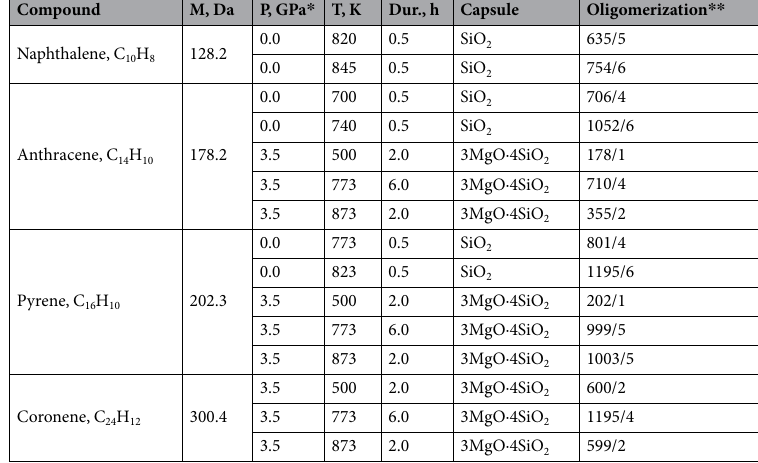
Table 1. The results of MALDI analyses. * 0.0 GPa = 1 bar. ** The numerator indicates the molecular weight of the largest determined oligomer with an intensity that exceed 1% of the maximum intensity; the denominator indicates the number of monomers presented in the